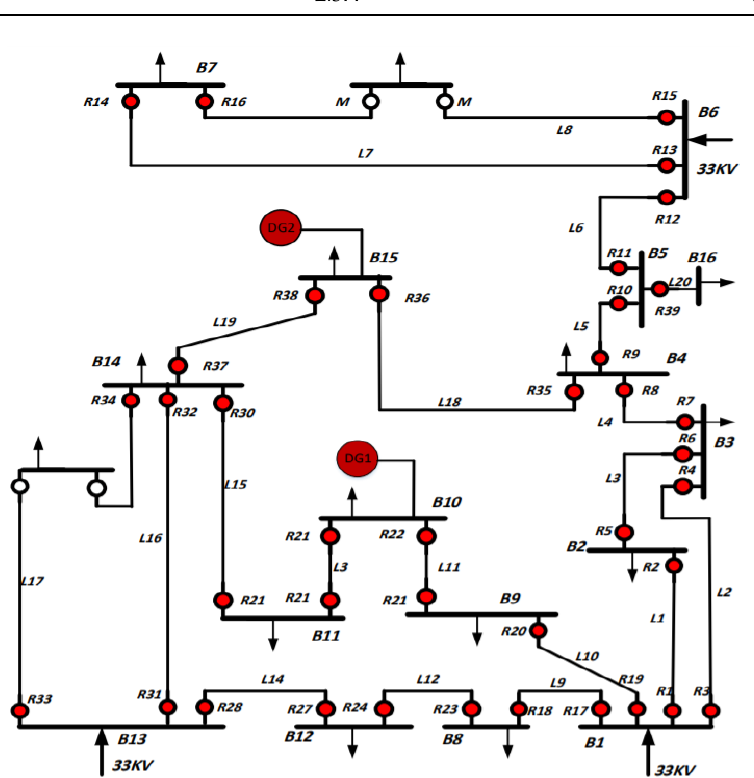
Figure 14. IEEE 30-Bus MG system (Large-Scale Network). Table 11. CTI for the Meshed 30-bus Test System.